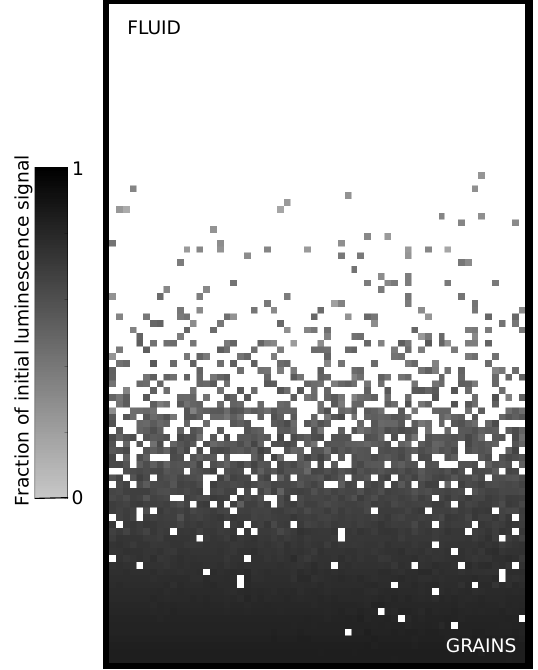
Figure 8. Model of turbulent sediment suspension, showing the computed luminescence signal after 20s of stirring and bleaching. The original luminescence signal is removed (bleached) by expo- sure to light. Because light intensity declines exponentially from top to bottom, grains near the bottom are less fully bleached than those near the top. Turbulent mixing disperses the partially bleached